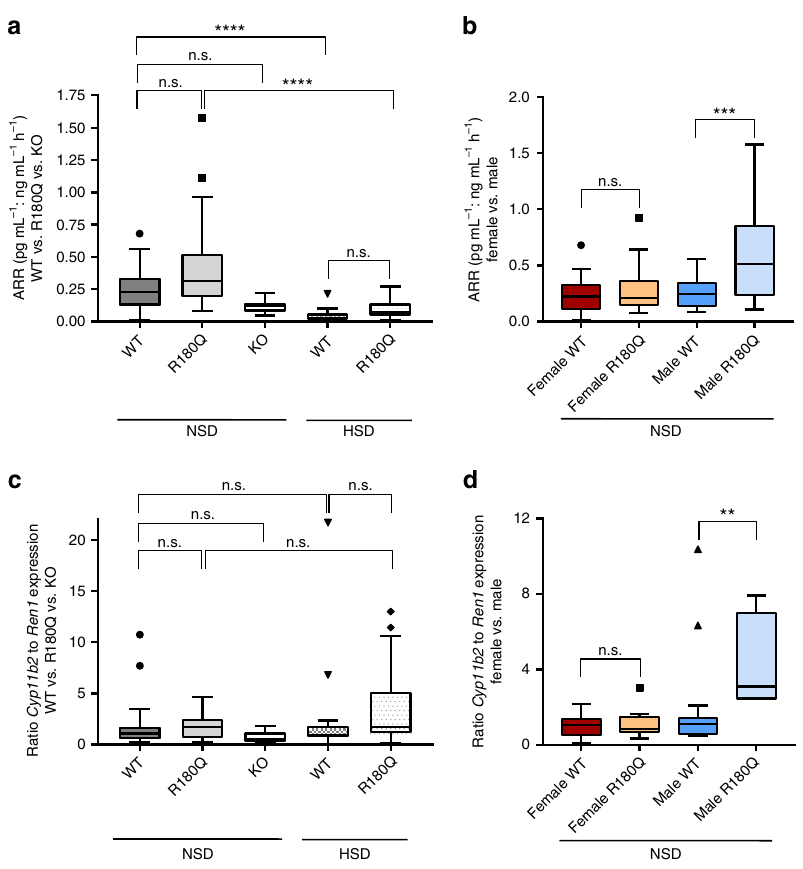
Fig. 5 Male Clcn2 R180Q/ + mice have elevated aldosterone:renin ratios. a Aldosterone:renin ratios (ARR) were calculated using values of plasma aldosterone levels and PRC. No signi fi cant differences were detected for Clcn2 R180Q/ + mice compared to WT under normal salt (WT: N = 37; Clcn2 R180Q/ + : N = 36; P = 0.5892) as well as after HSD (HSD-WT: N = 19; HSD- Clcn2 R180Q/ + : N = 23; P = 0.3788; both Kruskal-Wallis test, Dunn´s MCP). In addition, ARR of Clcn2 − / − mice was not signi fi cantly changed compared to WT (WT: N = 37; Clcn2 − / − : N = 10; P = 0.2089; Kruskal – Wallis test, Dunn´s MCP). b Subgroup analysis showed increased ARR levels in male Clcn2 R180Q/ + mice compared to WT (WT: N = 16; Clcn2 R180Q/ + : N = 13; P = 0.0010; one-way ANOVA including Bonferroni´s MCP; F = 6.896; df = 69), but not in female mice (WT: N = 21; Clcn2 R180Q/ + : N = 23; P = 0.8346; one-way ANOVA including Bonferroni´s MCP; F = 6.896; df = 69). c A ratio of Cyp11b2 and Ren1 expression was calculated using fold change. There is no signi fi cant difference between Clcn2 R180Q/ + and WT mice as well as Clcn2 − / − compared to WT (WT: N = 32; Clcn2 R180Q/ + : N = 25; P = 0.8622; Clcn2 − / − : N = 10, P = 0.6780; Kruskal – Wallis test, Dunn´s MCP). After HSD, the ratio was slightly increased in Clcn2 R180Q/ + mice compared to WT (HSD-WT: N = 24; HSD- Clcn2 R180Q/ + : N = 27; P = 0.0711; Kruskal – Wallis test, Dunn´s MCP). d The ratio was signi fi cantly increased in male Clcn2 R180Q/ + mice